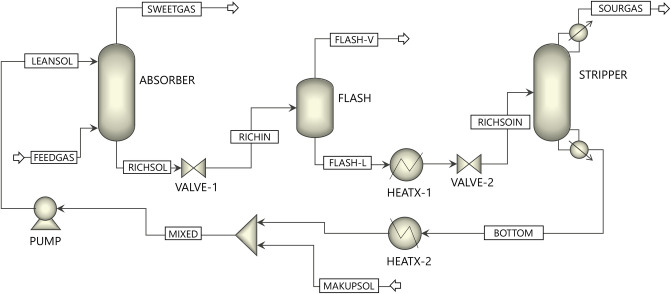
Scheme of the simulated plant (as from ASPEN PLUS).